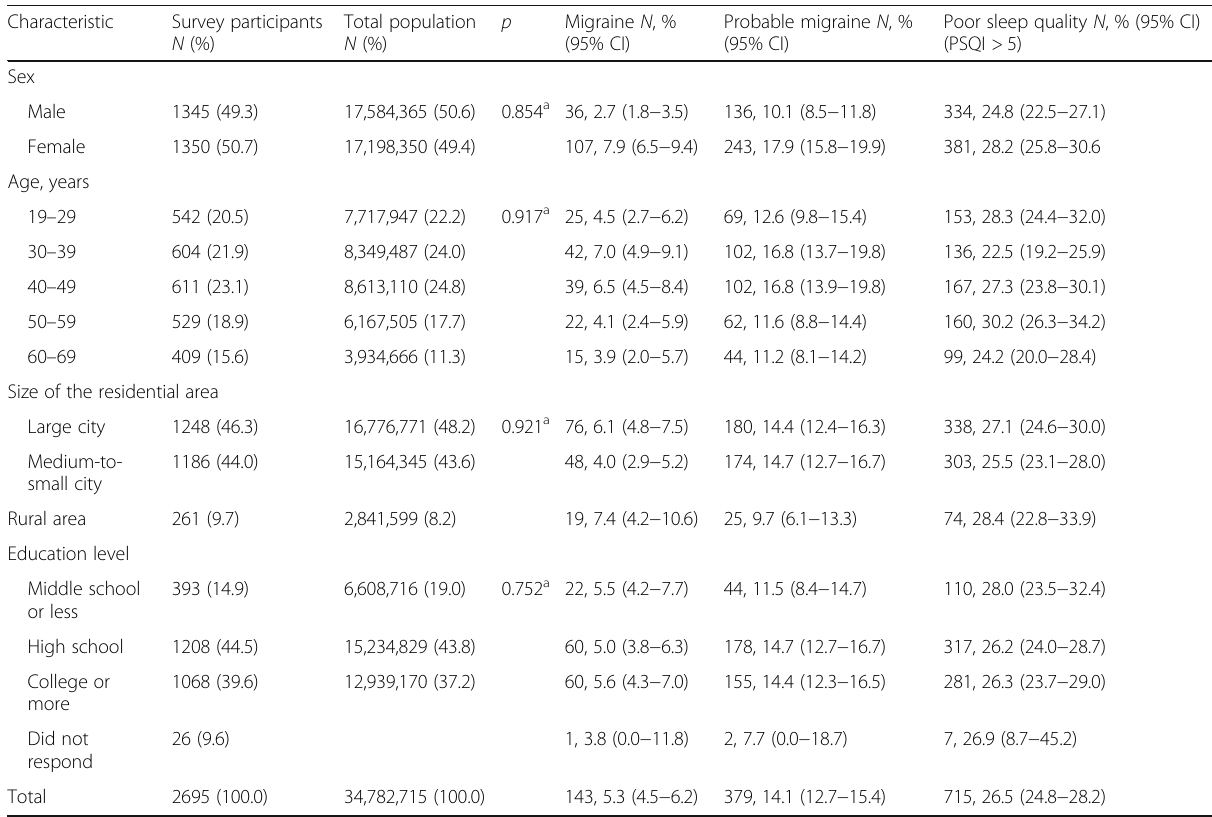
Table 1 Sociodemographic characteristics of survey participants, the total Korean population, and cases identified as having migraine, probable migraine, and poor sleep quality